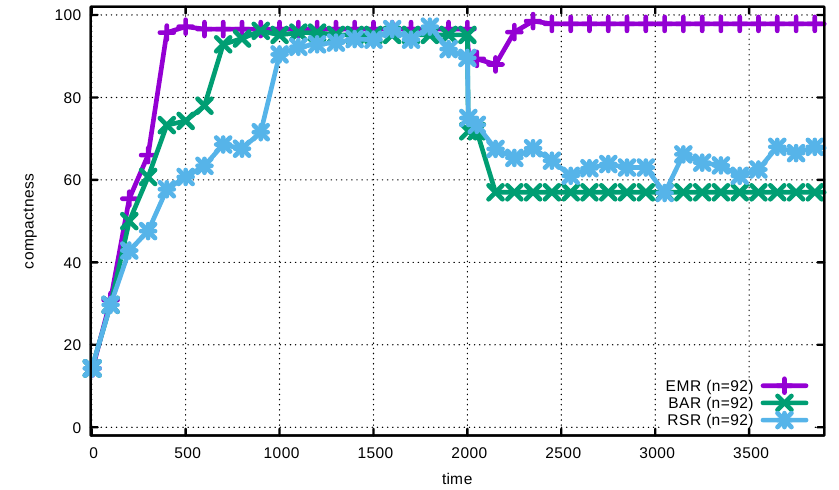
Fig. 13: Comparison of compactness before and after the self-healing process (a single